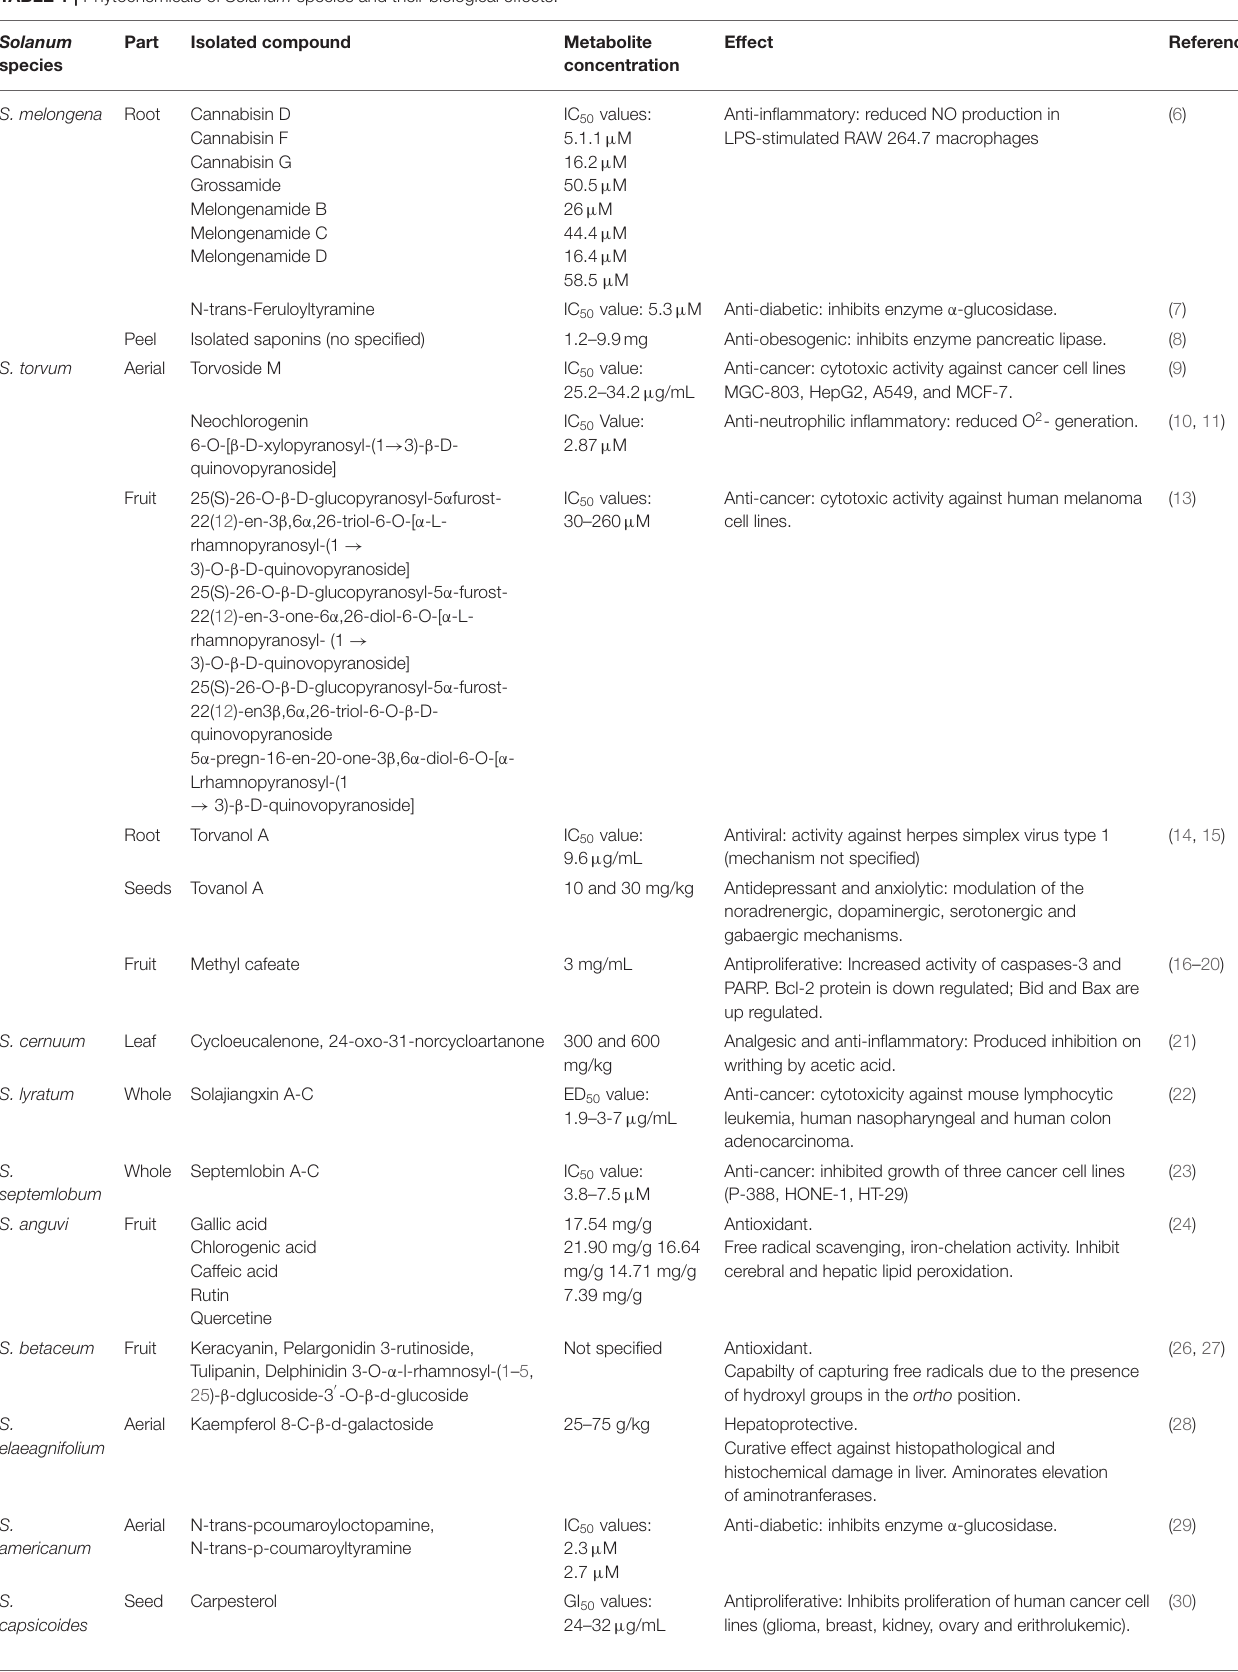
TABLE 1 | Phytochemicals of Solanum species and their biological effects. Solanum